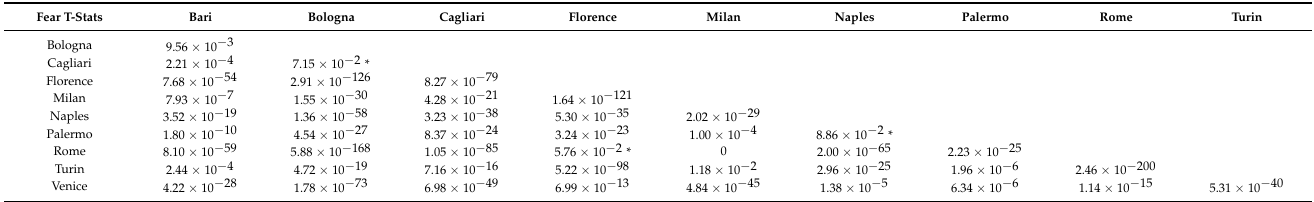
Table 1. Fear p -values.